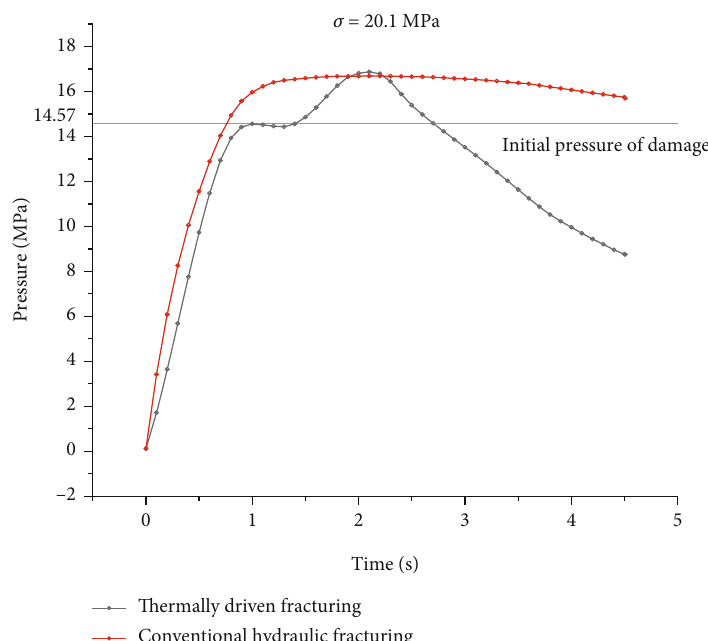
Figure 17: Pressure variation curves of thermally driven fracturing and hydraulic fracturing for a rock tensile strength of 20.1MPa.